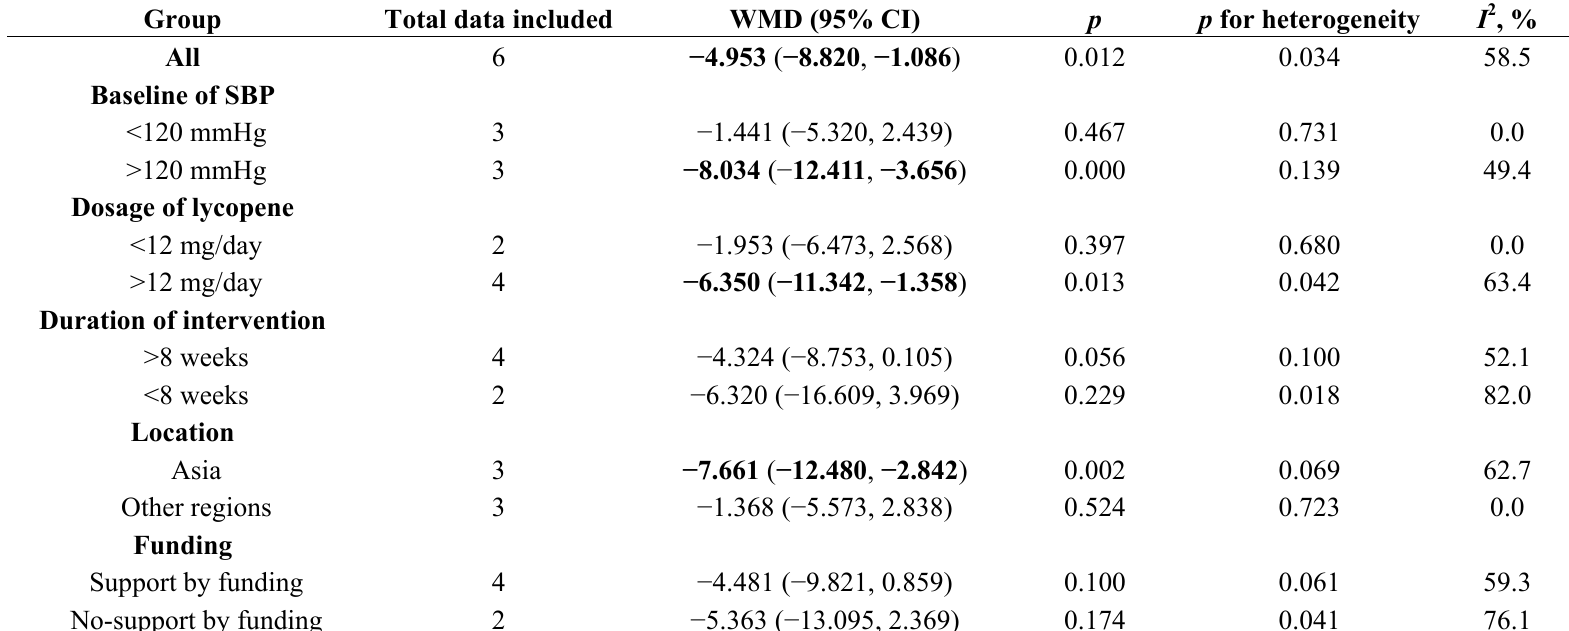
Table 3. Results of stratified analyses of the blood pressure, A: Systolic blood